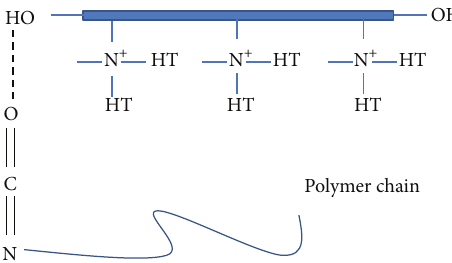
Figure 10: A possible interaction mechanism of hydrogen bonding between the PU chain and OMMT.